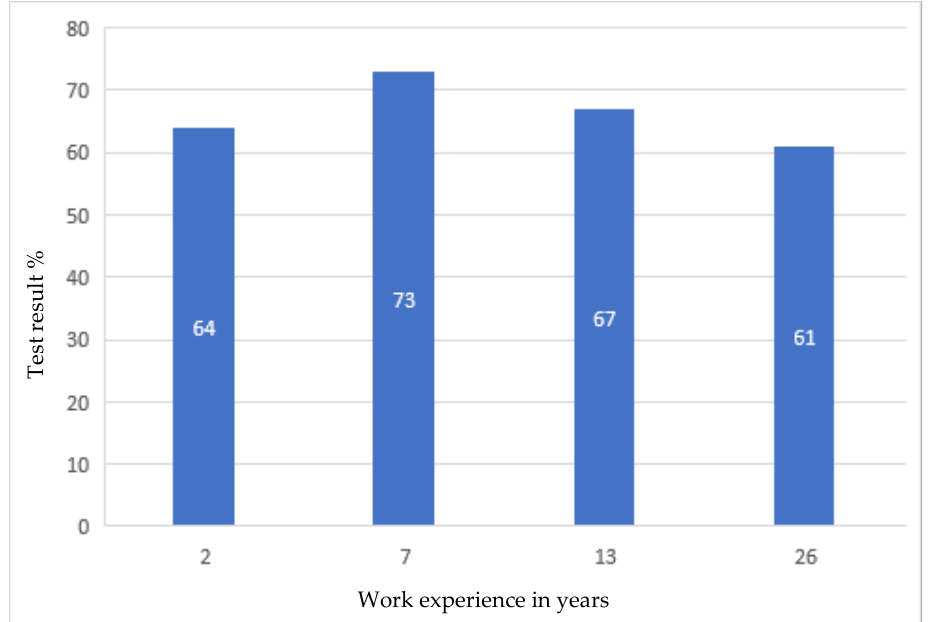
Figure 4. Research results regarding assembly and disassembly of the conveyor belt, depending on professional experience.